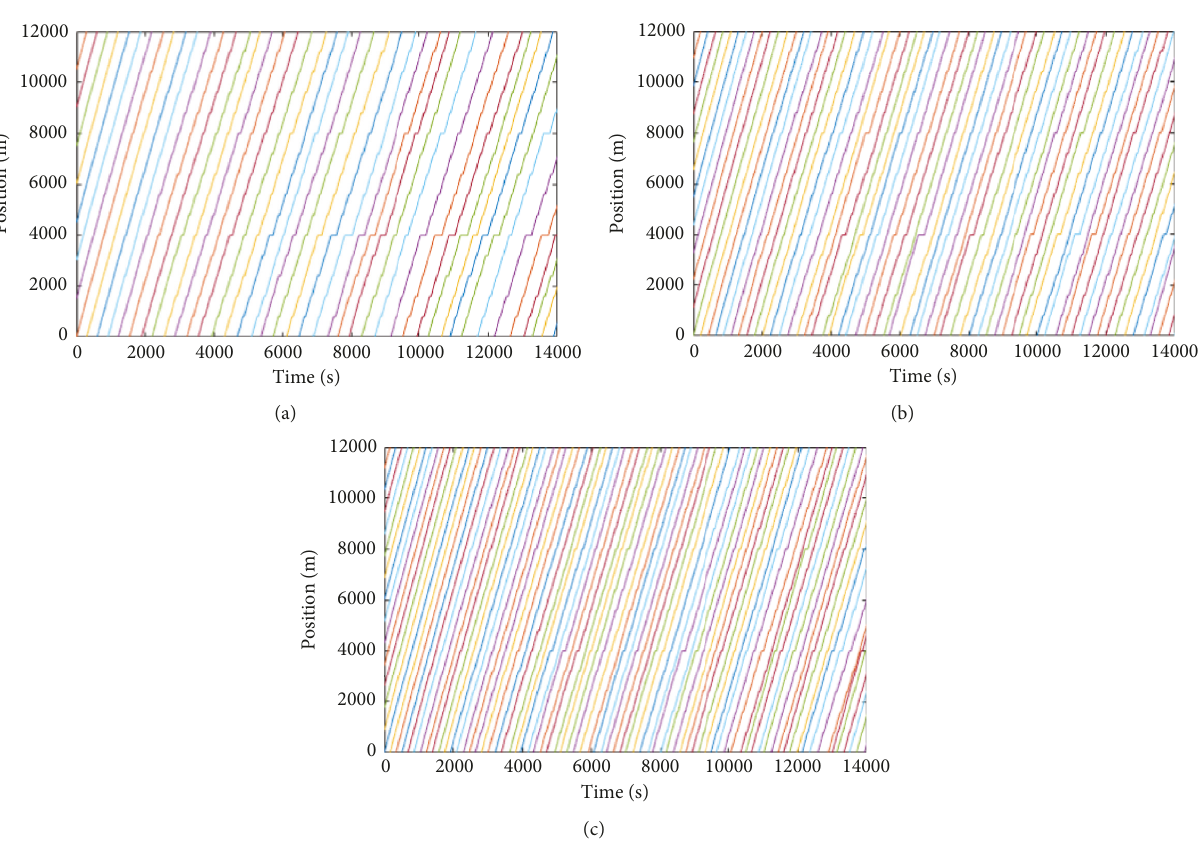
Figure 5: Spatiotemporal trajectory of buses. (a) With 8 buses on the bus route. (b) With 11 buses on the bus route. (c) With 14 buses on the bus